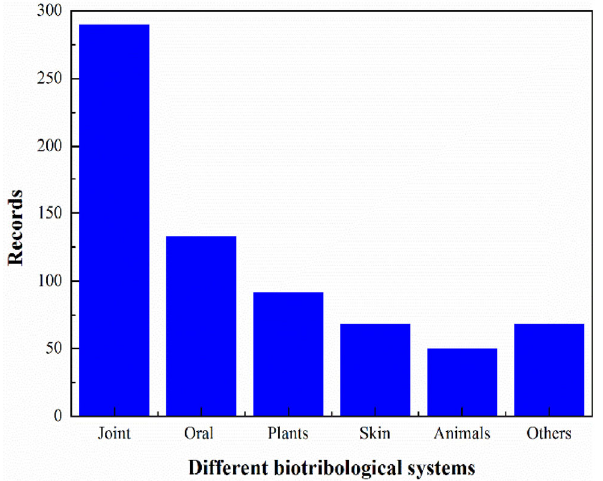
Fig. 20 Number of records in different areas searched from Web of